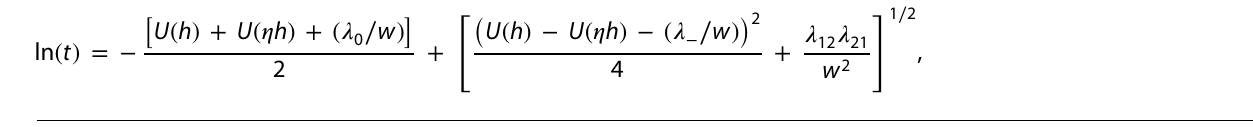
||ab/H ||c; the c2 c2